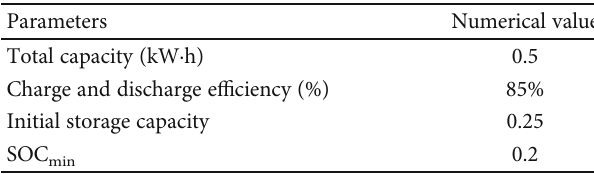
Table 3: Battery parameters.